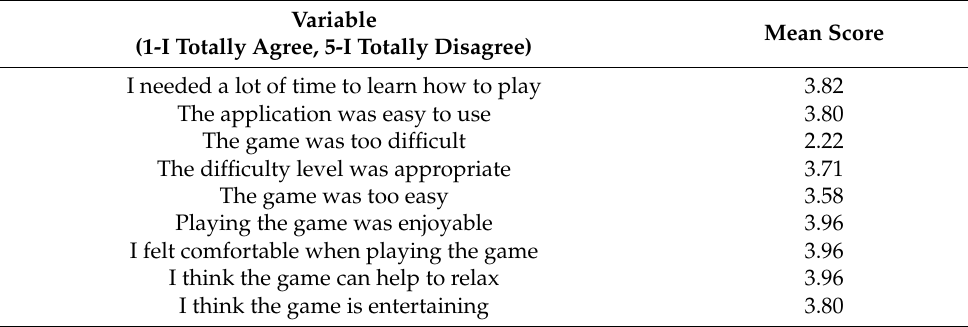
Table 3. The game evaluation questionnaire summary.